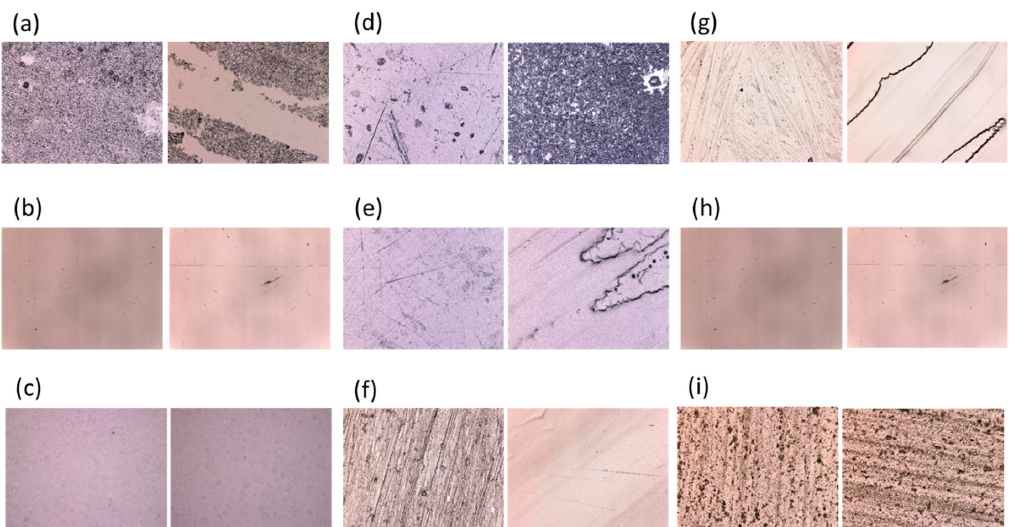
Figure 3. Laser microscope images with ×20 magnification, showing the effect of immersion treatment, in 1.0 M KOH held at 60 °C for 7 days, on several sealing and encasement materials that could be used for PEC devices. The specimens are arranged with the initial state and the exposed state on the left and right, respectively. ( a ) LOCTITE ® EA 9492 non-conductive adhesive on glass, ( b ) EPDM, ( c ) Coveme Tedlar Dymat ® PV backsheet, (d) 3-D printed polypropylene based, Rigur, ( e ) Objet RGD525 HT, ( f ) VeroBlack, ( g ) 3-D printed PMMA derivative (VeroClear), ( h ) bulk PMMA ( i ) 316L stainless steel. The starting materials for all 3-D printed polymers in ( d ) to ( g ), inclusive, are manufactured by Stratasys.